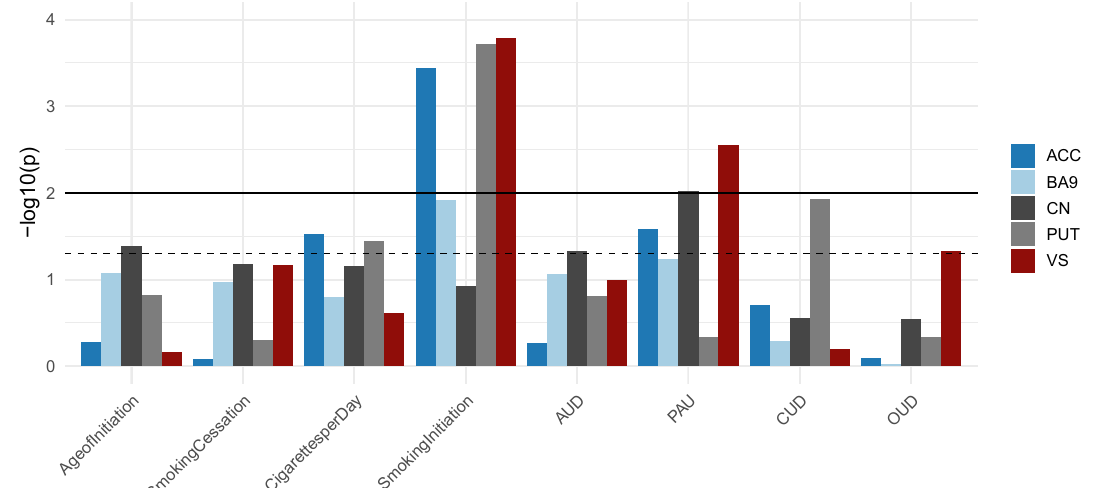
Figure 4. Summary of the results from GWAS enrichment analysis. For each brain region and each GWAS, the statistical significance of enrichment is shown. Dashed line represents nominal significance ( p < 5 × 10 − 2 ) while the solid line depicts the significance threshold after Bonferroni correction for multiple testing ( n = 8, p < 6.25 × 10 − 3 ). AUD, alcohol use disorder; PAU, problematic alcohol use; CUD, cannabis use disorder; OUD, opioid use disorder. Table 3. Associations of the predictor CpG sites in blood and